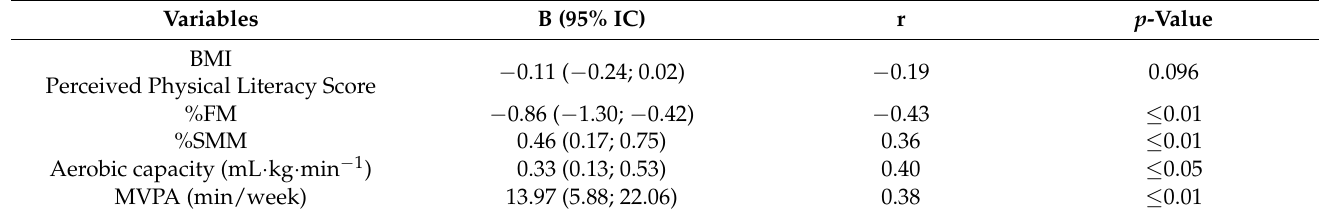
Table 2. Associations, between PLL and the dependent variables: BMI, %FM, SMM, aerobic capacity, and MVPA per